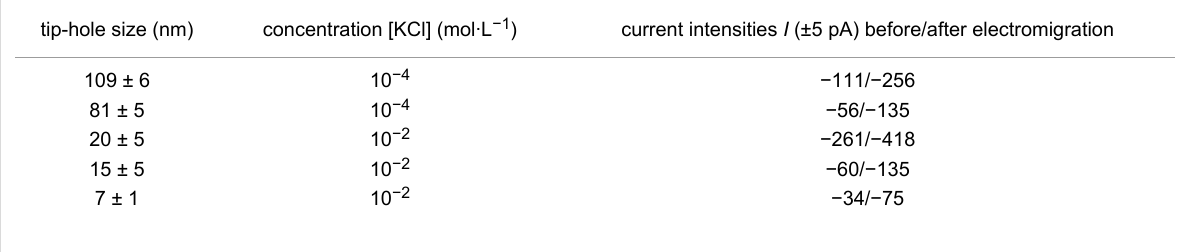
tip-hole size (nm)